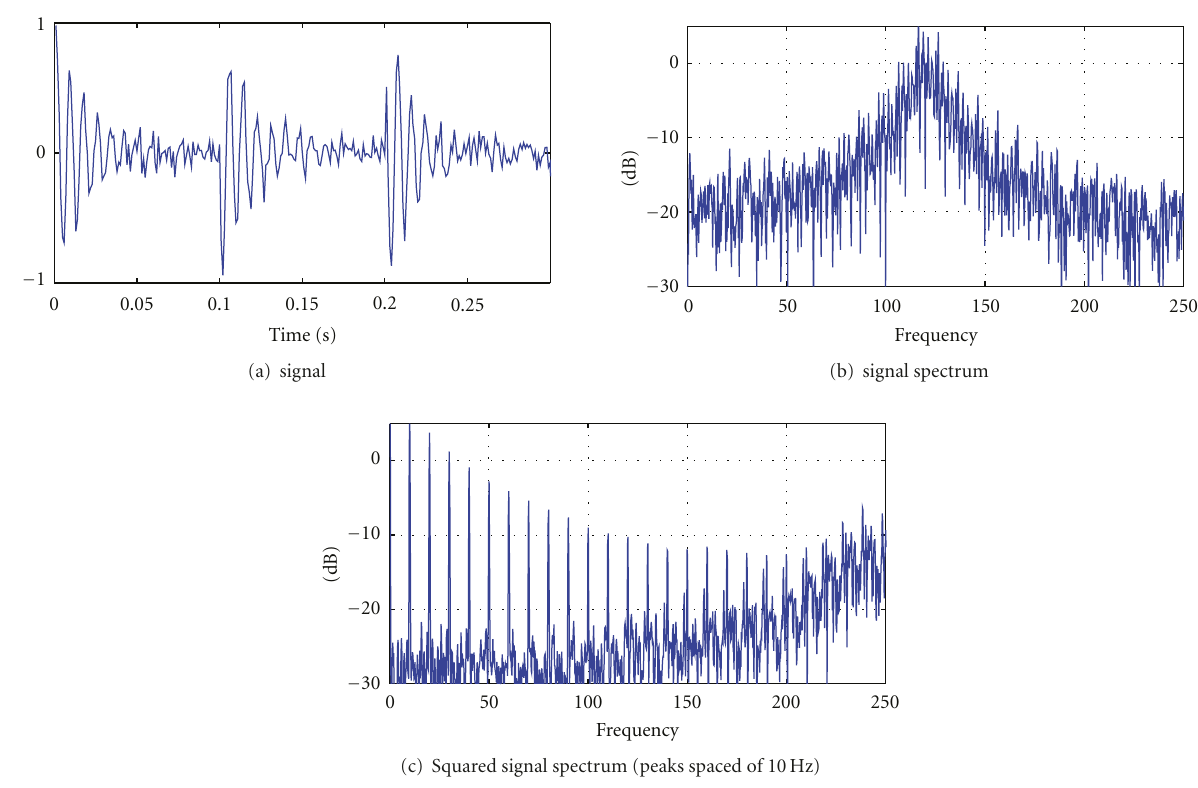
Figure 3: Impacts with random initial phase for sine waves.